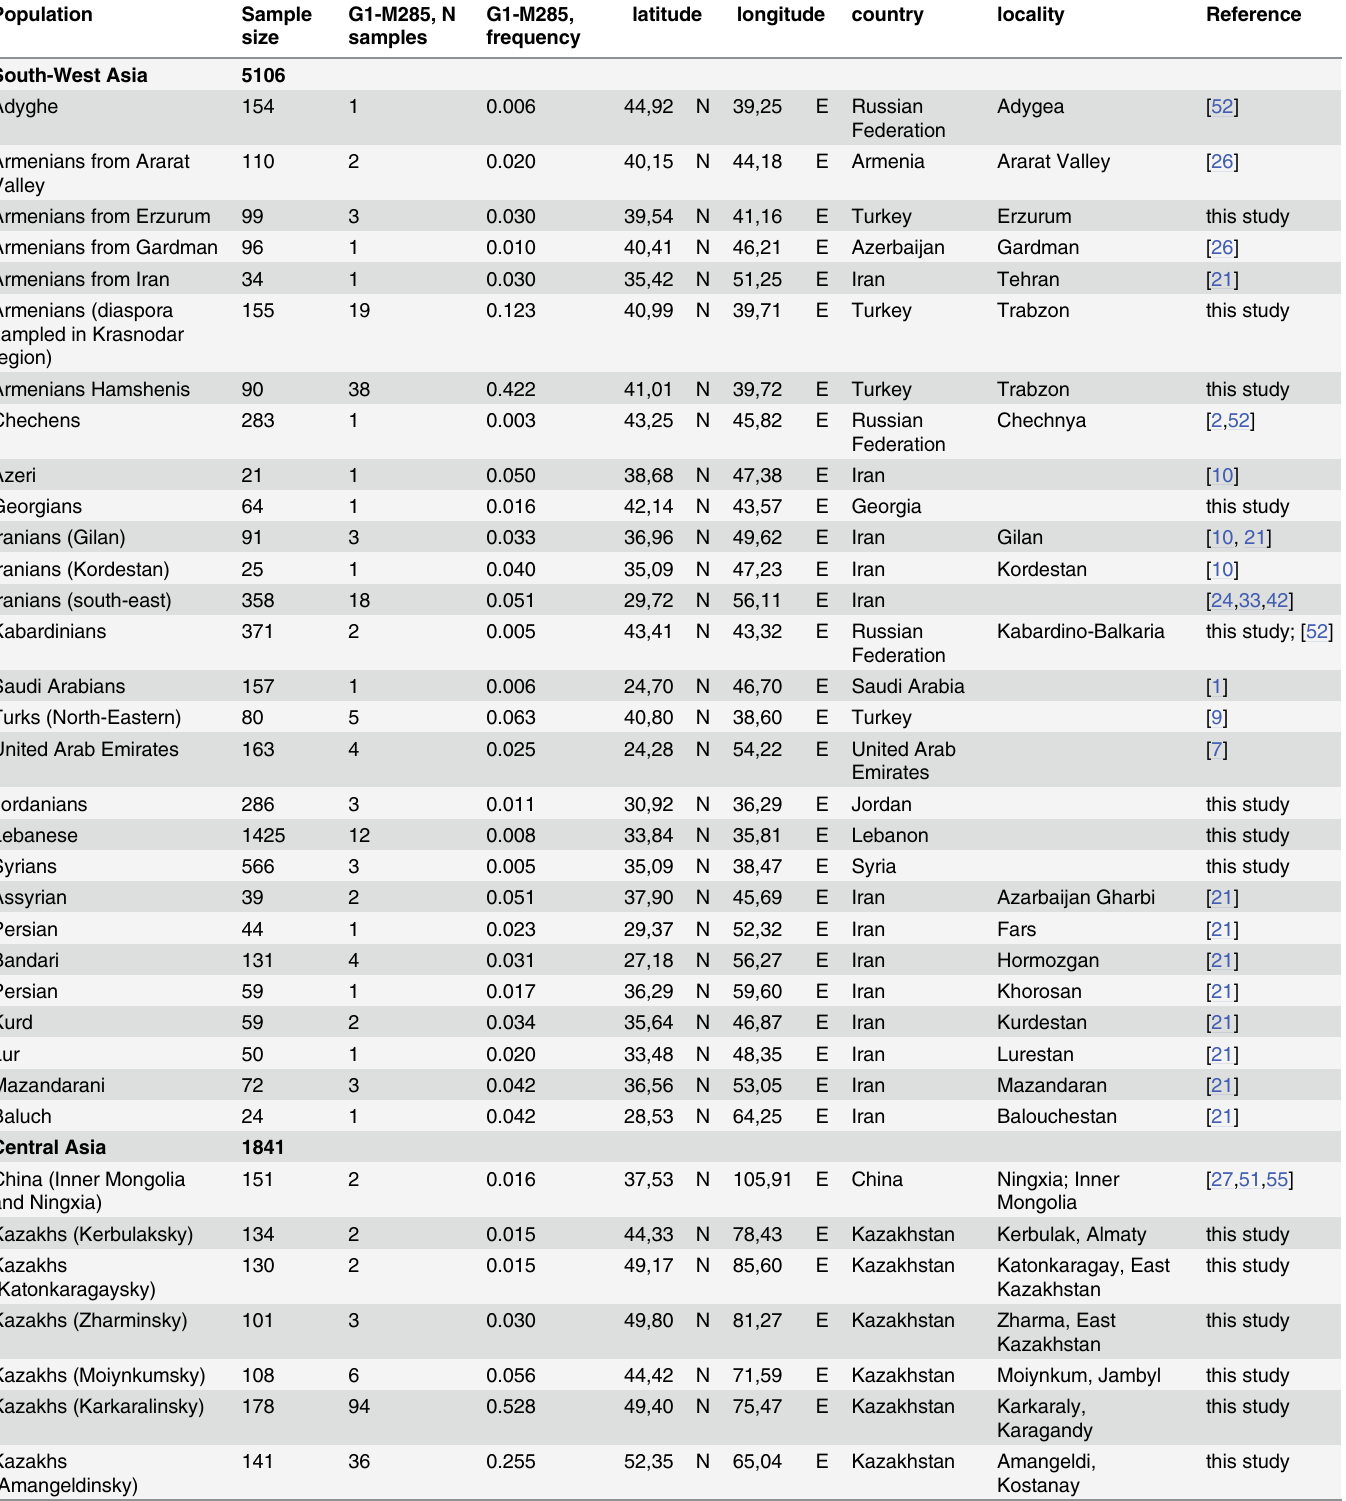
Table 1. Frequencies of the haplogroup G1-M285 in Eurasian